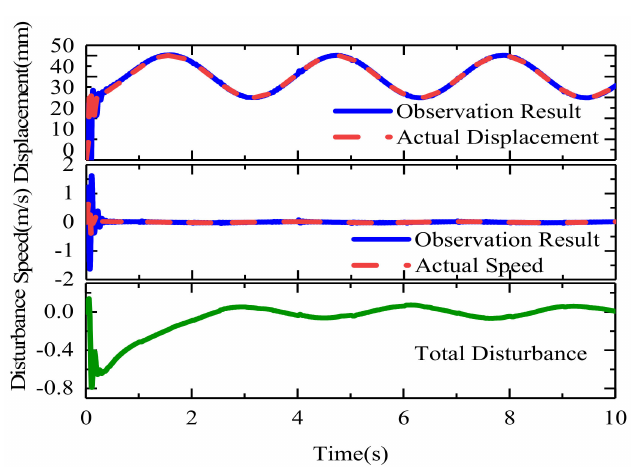
Figure 22. Error and controller output.